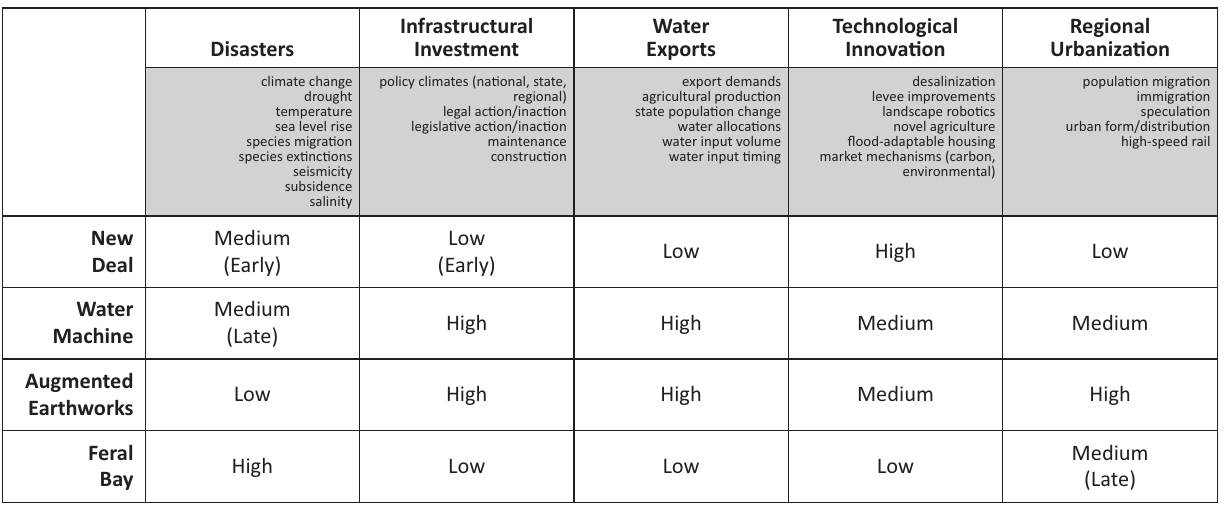
Figure 10. Drivers (top) and four exploratory scenarios developed for the wicked ecologies project. The “water machine” scenario explores future possibilities in which significant investment is made in Delta infrastructure, with the primary goal of ensuring the stability of water exports. Climate change and earthquakes stress this water machine while land use frag- ments and diversifies, with some tracts surviving essentially intact while others are converted to novel uses ranging from open deep-water habitats to linear urbanization along super-levees (from Milligan & Holmes, 2016).